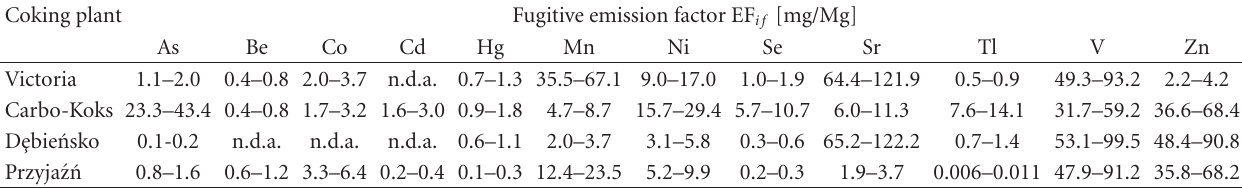
Table 6: Ranges of fugitive emission factors EF if of the selected trace